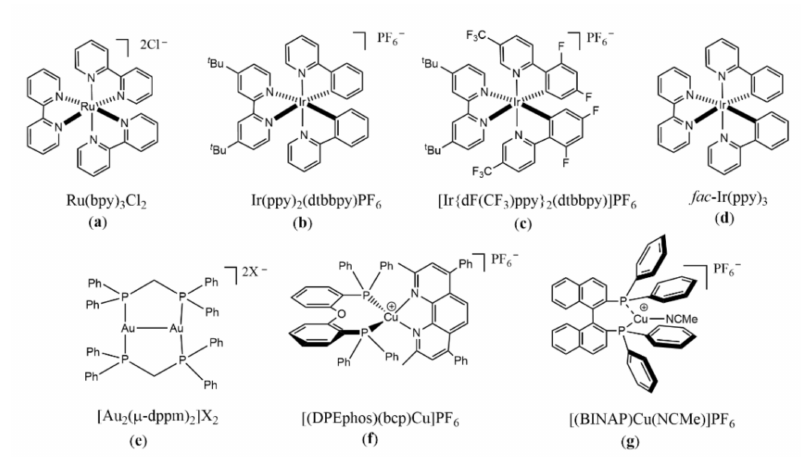
Figure 2. The structure of organometallic photocatalysts. ( a ) Ru(bpy) 3 Cl 2 ; ( b ) Ir(dtbbpy)(ppy) 2 PF 6 ( c ) [Ir{dF (CF 3 )ppy} 2 (dtbbpy)]PF 6 ; ( d ) fac -Ir(ppy) 3 ; ( e ) [Au 2 ( µ -dppm) 2 ]X 2 ; ( f ) [(DPEphos)(bcp)Cu]PF 6 ; ( g ) [(BINAP)Cu(NCMe)]PF 6 .